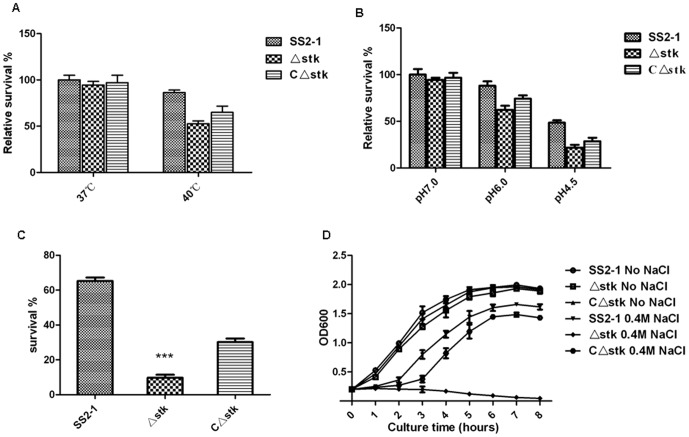

In vitro stress experiments.(A) Thermal stress assay. Bacteria were grown in THY broth to the mid-exponential phase. Aliquots of the appropriate size were diluted to an OD600 of 0.1 with approximately 10 mL of fresh THY broth. All of the cultures were incubated for 12 h at 37°C and 40°C, the number of colony forming units (CFU) per millimeter was determined. (B) Acid tolerance assay. Cultures were harvested at mid-exponential phase by centrifugation at 4000 g at 4°C for 10 min, washed once with 0.1 M glycine buffer (pH 7.0), and then subjected to acid killing by incubating the cells for 45 min in THY of different pHs. Surviving cells were appropriately diluted and plated on THY agar plates. (C) Oxidative stress assay. Bacterial cells were grown in THY medium at 37°C to an OD600 of 0.6 and the aliquots (107 CFU) were used in each assay. Cells were incubated at 37°C for 20 min without or with 40 mM H2O2, and viable counts were carried out. Experiments were performed in duplicate and repeated three times. (D) Osmotic stress assay. Growth curves as measured by the ODs of the SS2-1, Δstk and CΔstk grown in THY and THY plus 400 mM NaCl. The growth of cultures was monitored from an initial OD600 of 0.2. Data are representative of three independent experiments.